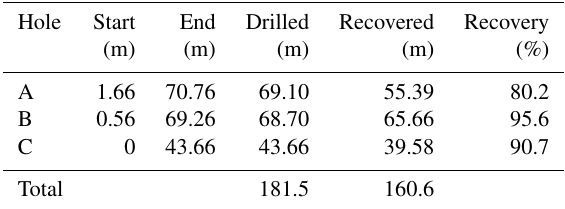
Table 1. Summary of holes drilled and core recovery at Darwin Crater site